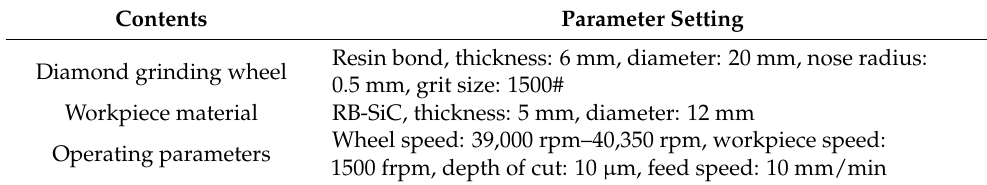
Table 1. Grinding operating conditions.